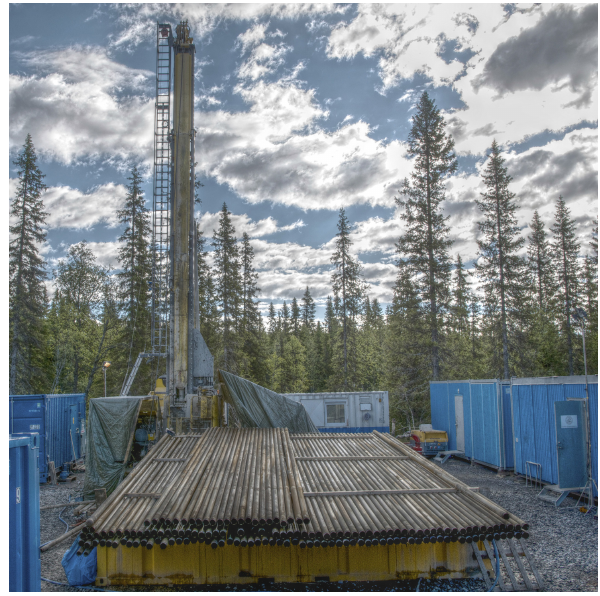
Figure 5. Sketch of the COSC-1 drill site. The working area of the drill site is nearly quadratic with an area of about 1050m 2 . The drill rig, the combined mud tanks and manual pipe handling system and some peripherals such as workshop and mud mixer formed the cen- tral part of the drill site. In immediate proximity to the northwest, the BugLab container (Mangelsdorf and Kallmeyer, 2010) was lo- cated. It hosted OLGA, the online gas monitoring system (Erzinger et al., 2006; Wiersberg and Erzinger, 2011), and provided space for microbiological work and mud sampling. The southeastern part of the drill site was occupied by common facilities and office space.